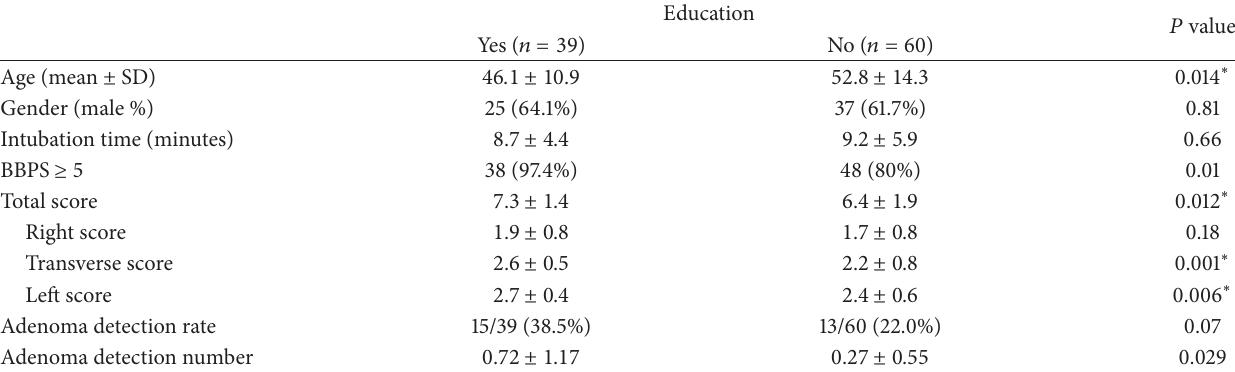
Table 1: Baseline characteristics of the study patients and the effect of education on the outcome of bowel preparation and